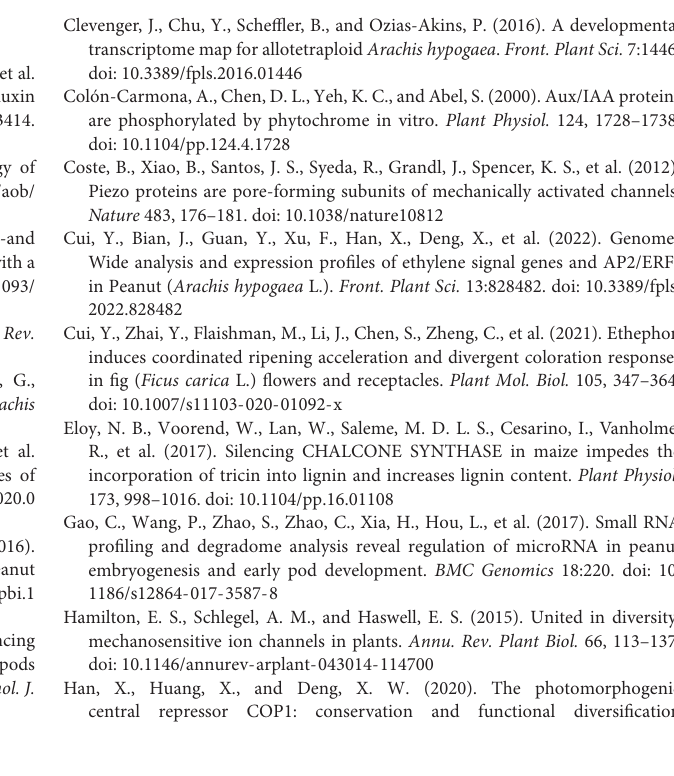
Supplementary Table 8 | The calmodulin-related DEGs identified in this study. Supplementary Table 9 | The DEGs enriched in plant hormone signal transduction. Supplementary Table 10 | The relationship between genes and modules. MM: module membership, the closer the value is to 1 or − 1, the gene is strongly associated with the module (positive or